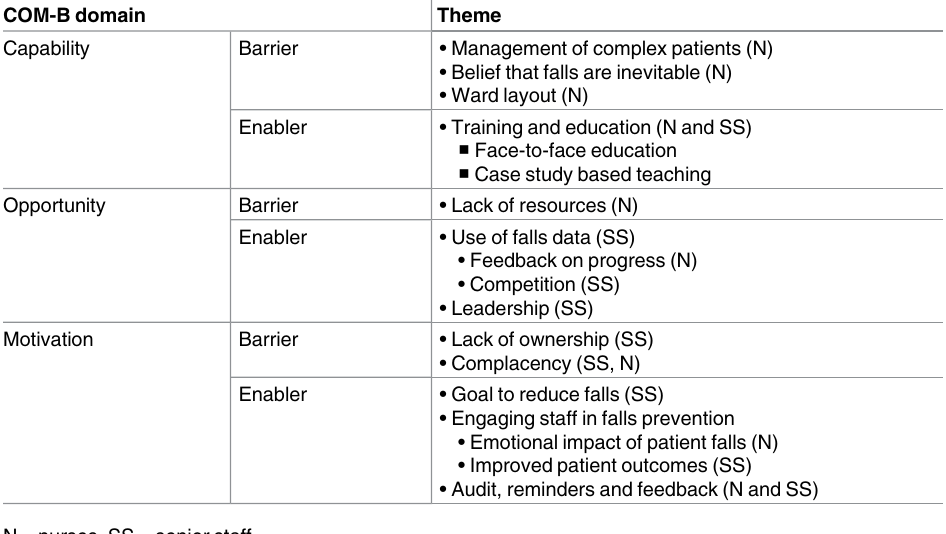
Table 2. Mapping of barrier and enabler themes to COM-B